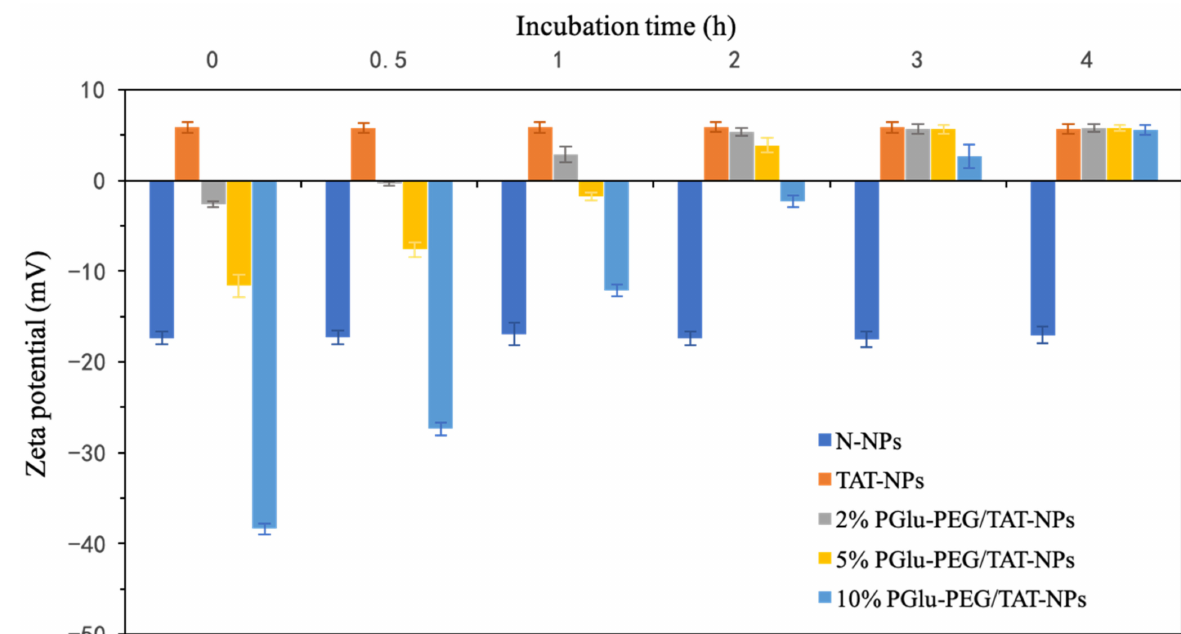
Figure 2. Changes in zeta potential of DSF-loaded N-NPs, TAT-NPs, PGlu-PEG/TAT-NPs with 2%, 5%, and 10% PGlu- PEG coating in pH 6.5 PBS during 4 h ( n = 3). N-NPs, DSF-loaded naked nanoparticles; TAT-NPs, DSF-loaded cationic nanoparticles; PGlu-PEG/TAT-NPs, DSF-loaded shell/core composite nanoparticles.